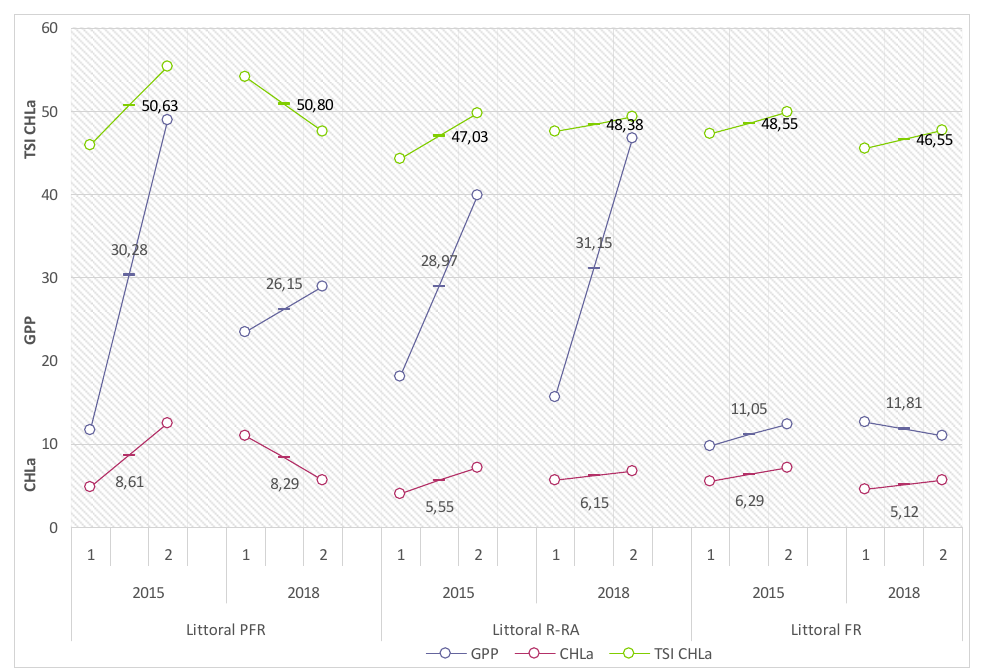
Figure 6. Mean values with ranges of biological indicators of the trophic status of waters of the littoral in sectors of the catchment of Lake Piaseczno in the 2015 and 2018 summer seasons: GPP, Gross Primary Production (mg C ass · m − 2 · h − 1 ); CHLa, chlorophyll a concentration (mg Chl. a · m − 2 ); TSI CHLa, Carlson’s Trophic State Index.